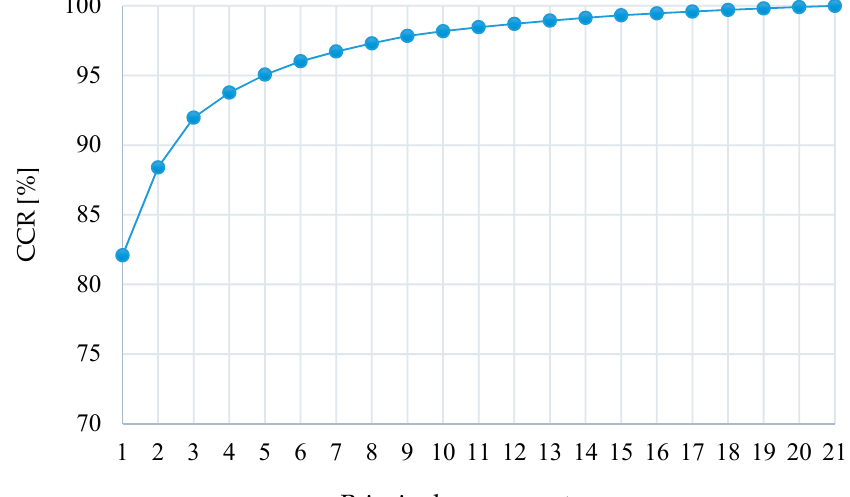
Figure 7. Cumulative contribution rate (CCR) of the SSM corresponding to the number of principal components; the SSM can represent 95% shape variation from the first five PCs.